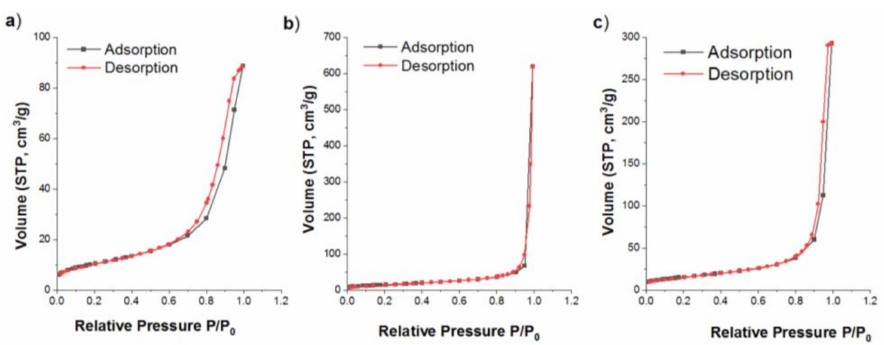
Figure 2. N 2 adsorption–desorption isotherms of ( a ) Fe 3 O 4 ( b ) TiO 2 and ( c ) TiO 2 –Fe 3 O 4